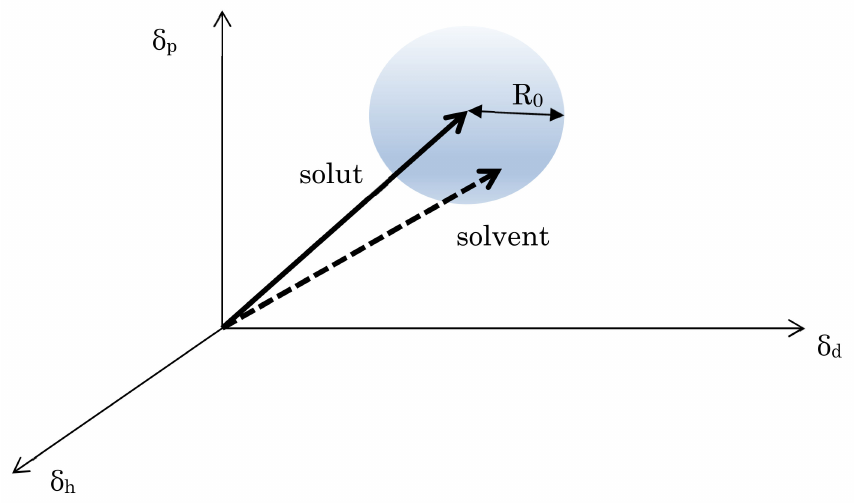
Figure 4. Outline of Hansen solubility parameter and interaction radius R 0